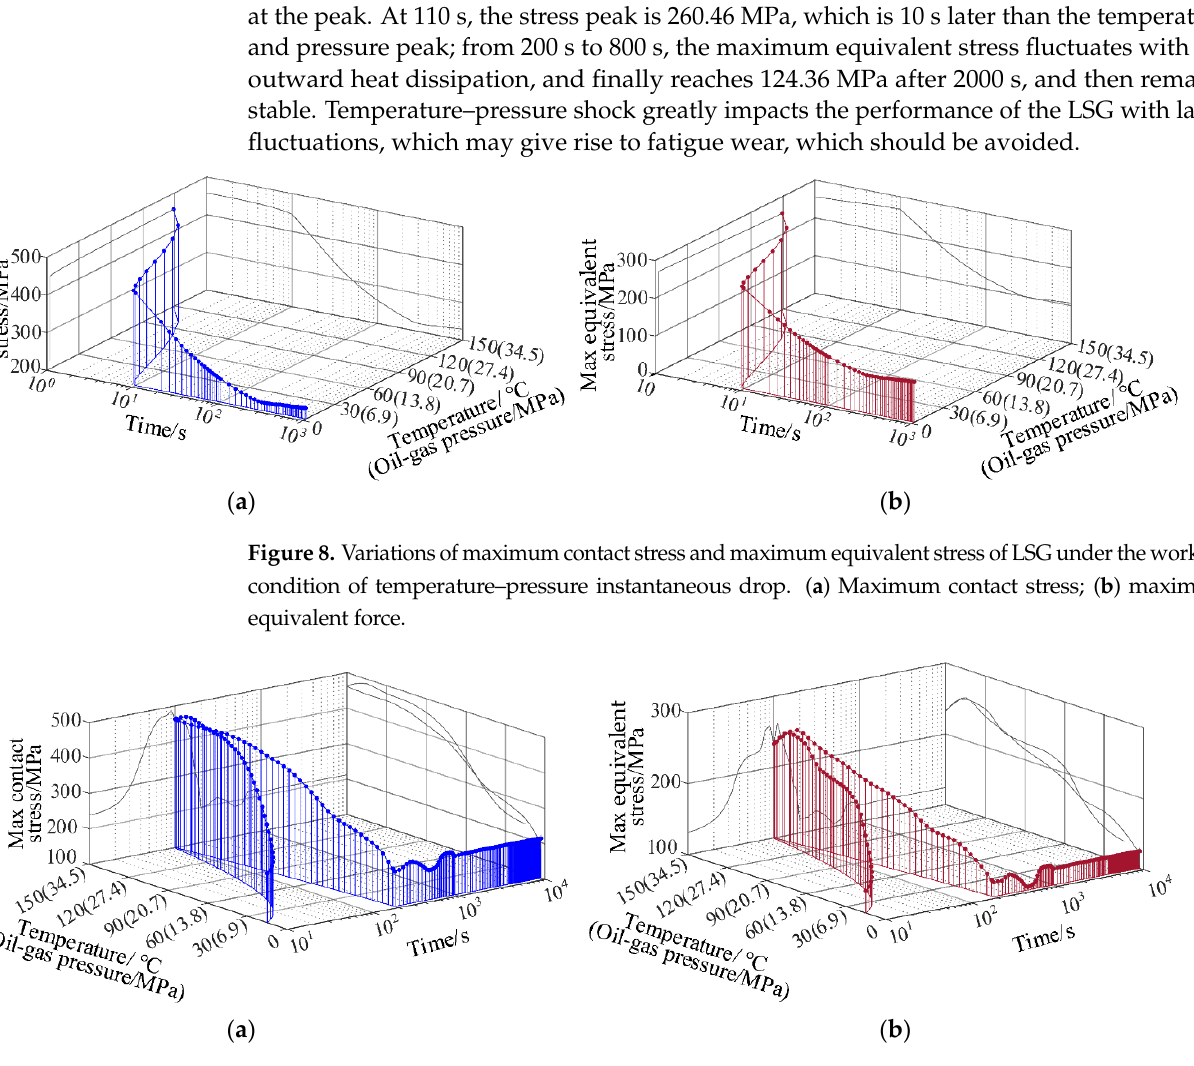
Figure 9. Variations of maximum contact stress and maximum equivalent stress of LSG under the working condition of temperature–pressure shock. ( a ) Maximum contact stress; ( b ) maximum equivalent